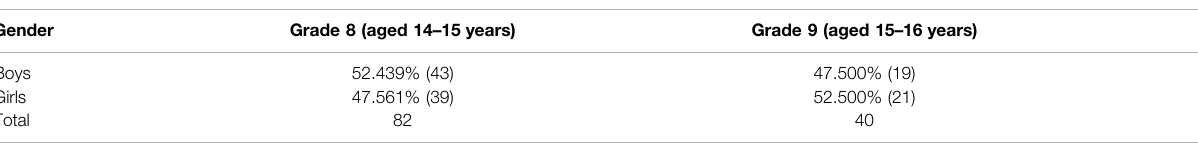
TABLE 1 | Gender distribution of the participants.